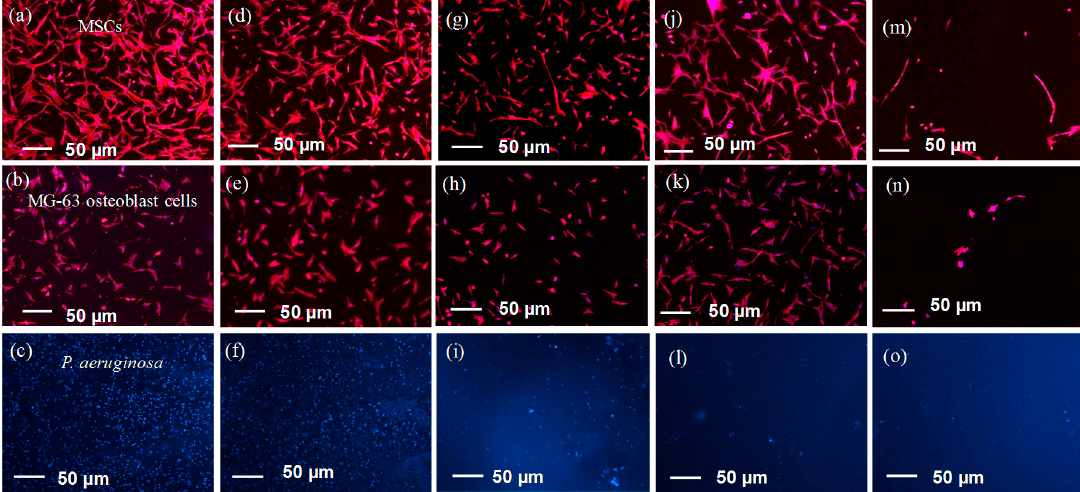
Figure 7. Epifluorescence images of human mesenchymal stem cell, MG63 osteoblast-like cell and P. aeruginosa attachment to PEG grafted under different conditions: ( a – c ) Si wafer control, ( d – f ) 4% APTES, ( g – i ) 4% APTES_PEG 0 M K 2 SO 4 , ( j – l ) 4% APTES_PEG 0.3 M K 2 SO 4 , and ( m – o ) 4% APTES_PEG 0.6 M K 2 SO 4 .